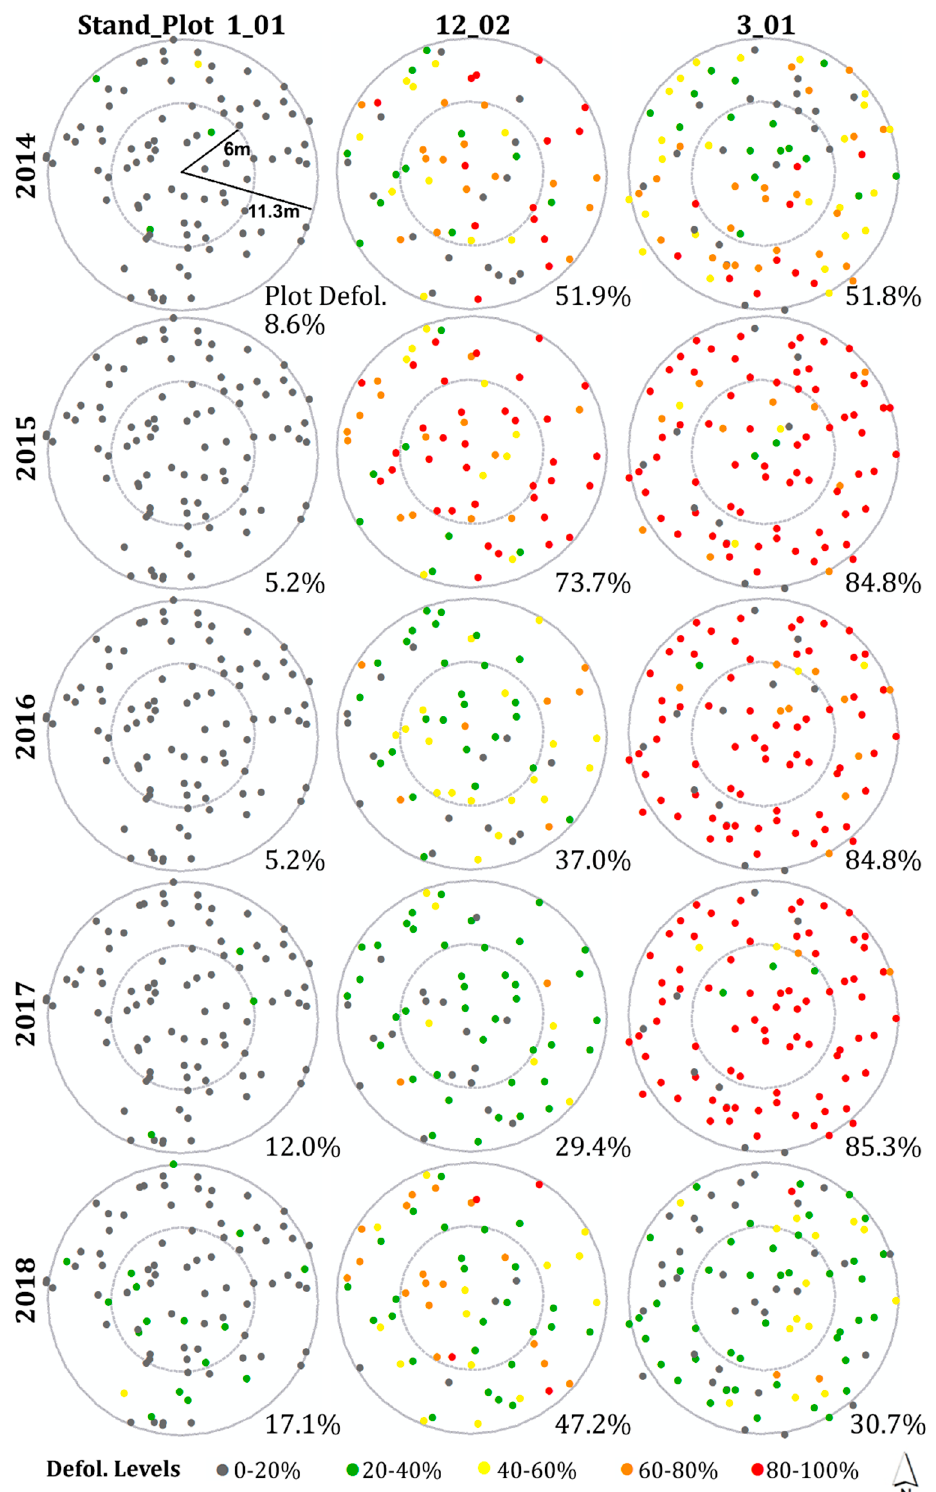
Figure 4. Stem maps of tree locations (diameter at breast height (DBH) ≥ 10 cm) of three example plots for five years, showing spatial distribution of defoliation. The three example plots were selected to represent generally low (1_01), moderate (12_02), and high (3_01) defoliation levels that contained hot spot and cold spot trees (shown in Figure 5).